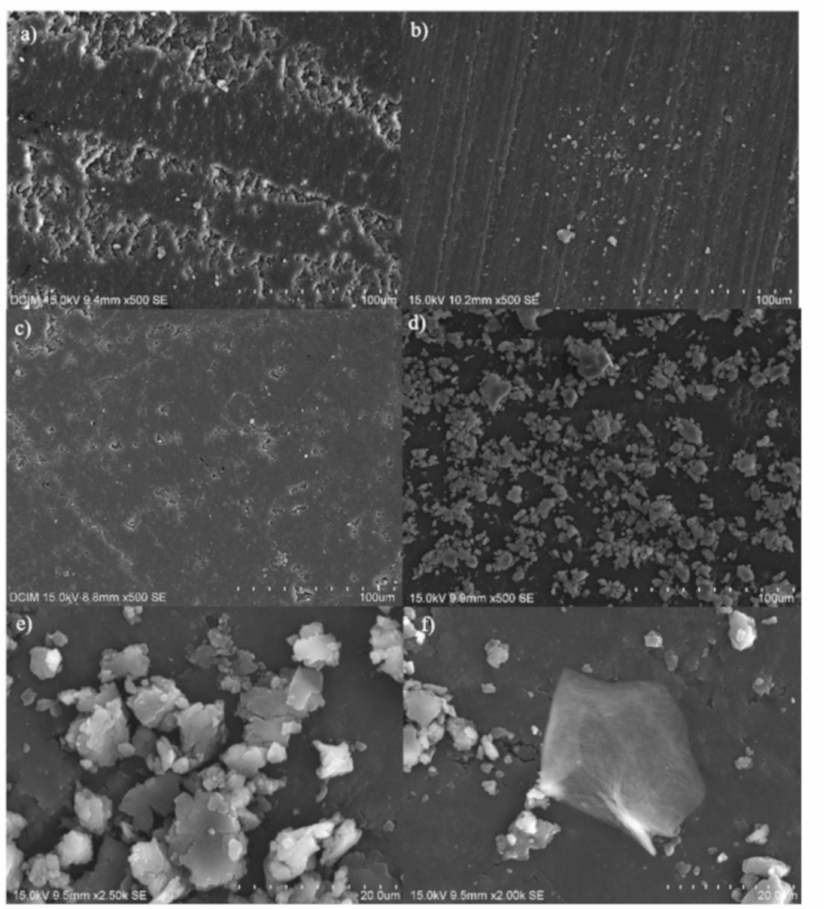
Figure 8. SEM images of worn surfaces of nanocomposites with 3 wt.% and 8 wt.% of non-functionalised GNPs ( a , c ) and amino-functionalised GNPs ( b , d ), respectively. SEM images of the debris particles detached during test ( e , f